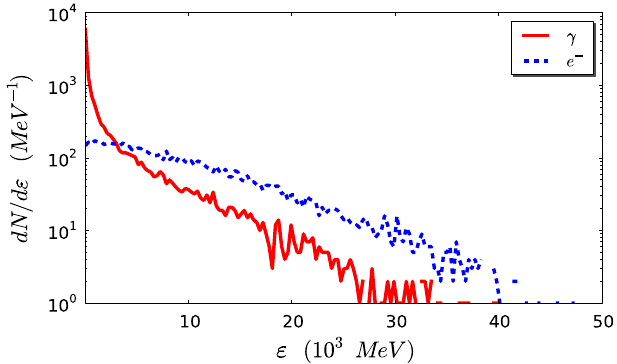
FIG. 6. The energy spectra for different components of the